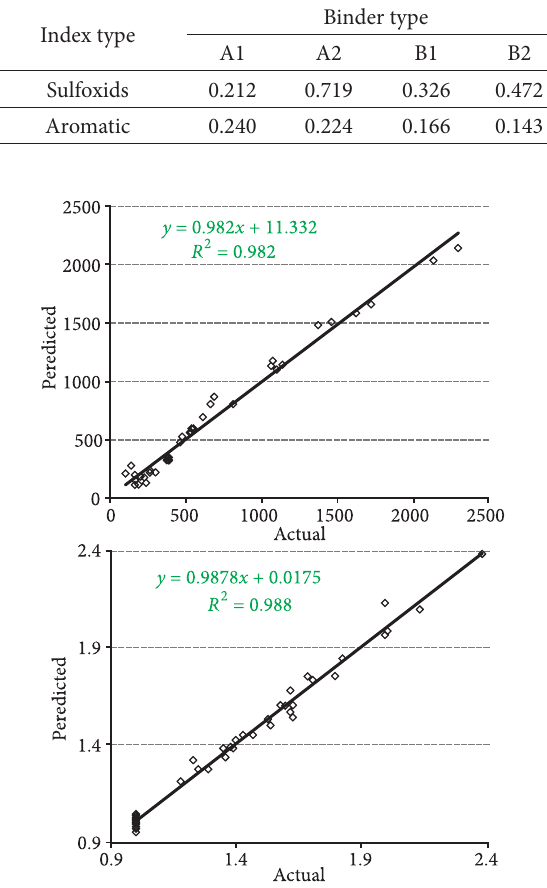
Fig. 6. Predicted viscosity and aging index versus actual